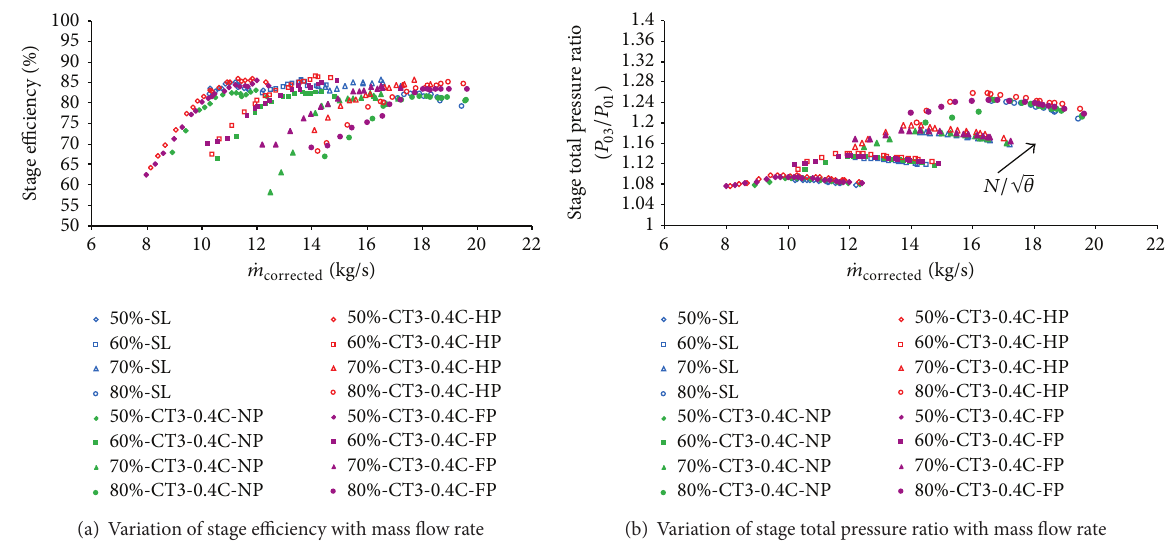
Figure 7: Compressor operating envelop with solid casing and casing treatment at 40% axial coverage.